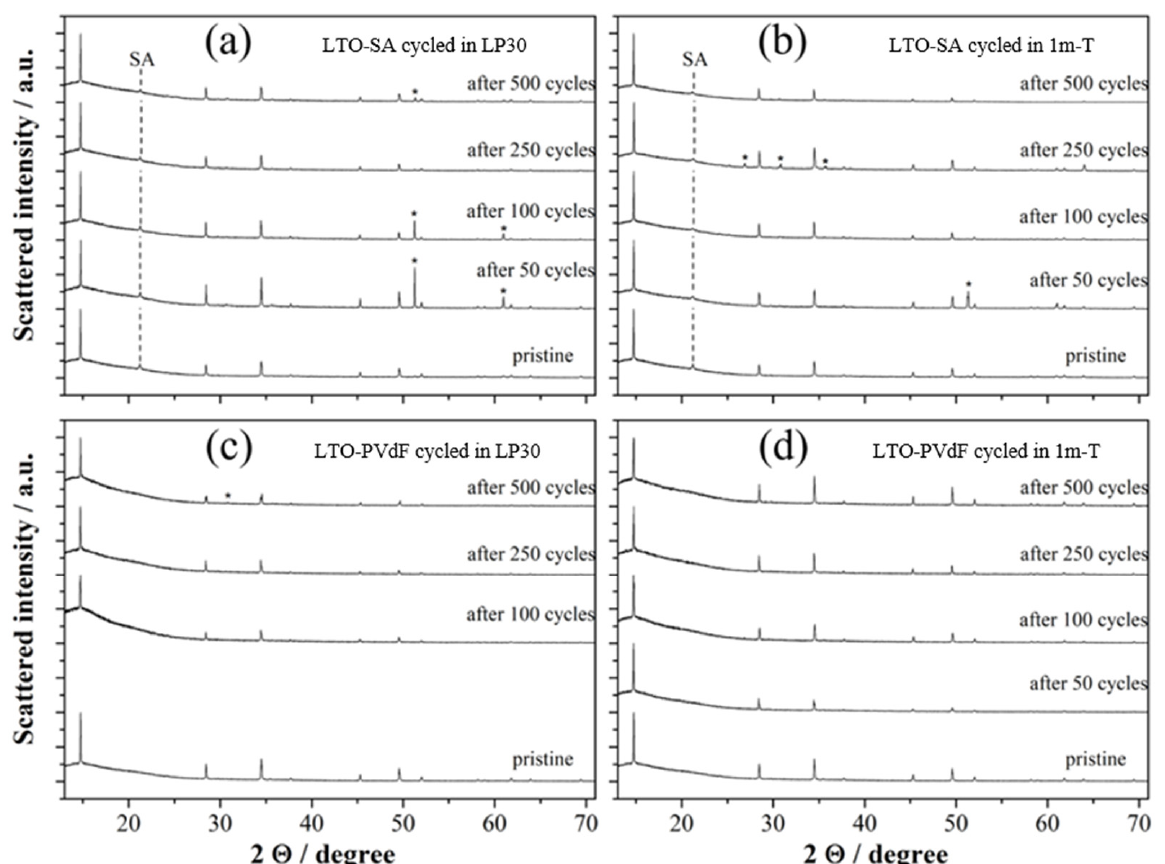
Figure 4. Synchrotron XRD patterns of LTO electrodes compared with pristine samples: ( a ) LTO ‐ SA electrodes cycled in LP30; ( b ) LTO ‐ SA electrodes cycled in 1m ‐ T; ( c ) LTO ‐ PVdF electrodes cycled in LP30; ( d ) LTO ‐ PVdF electrodes cycled in 1m ‐ T. Spurious reflection from aluminum are highlighted by asterisks.